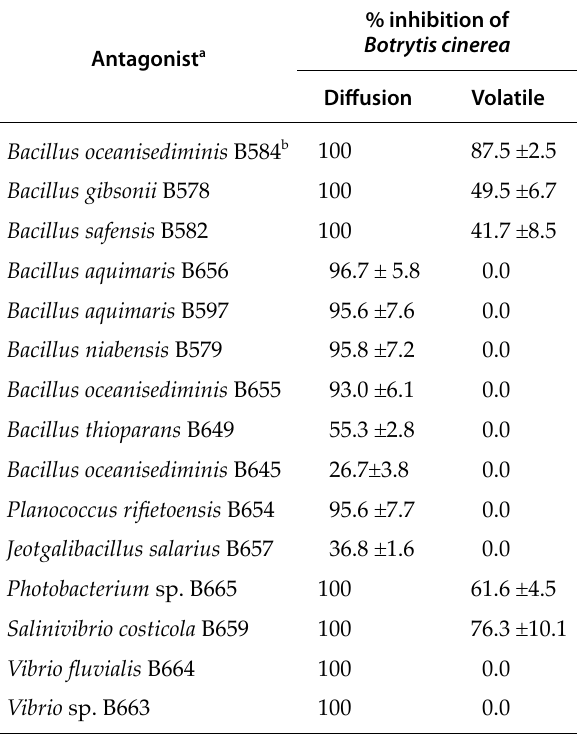
Table 2. Extracellular activities of 15 bacterial isolates from Morocco.